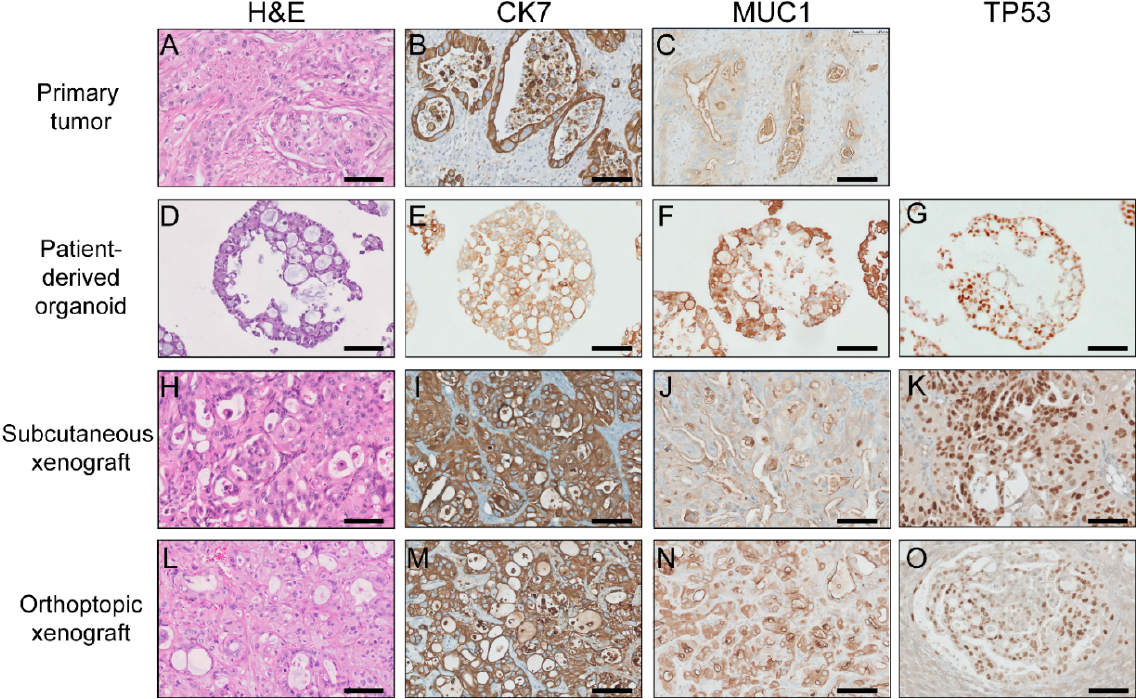
Figure 3. Histologic assessment of parental tumors, patient-derived organoids, and xenograft tumors in patient 83. Hematoxylin and Eosin staining (H&E) ( A , D , H , L ), immunohistochemistry staining of CK7 ( B , E , I , M ), MUC1 ( C , F , J , N ), TP53 ( G , K , O ) were performed on the primary tumor, patient-derived organoids, subcutaneous xenografts, and orthotopic xenografts. Scale bars, 100 µm.